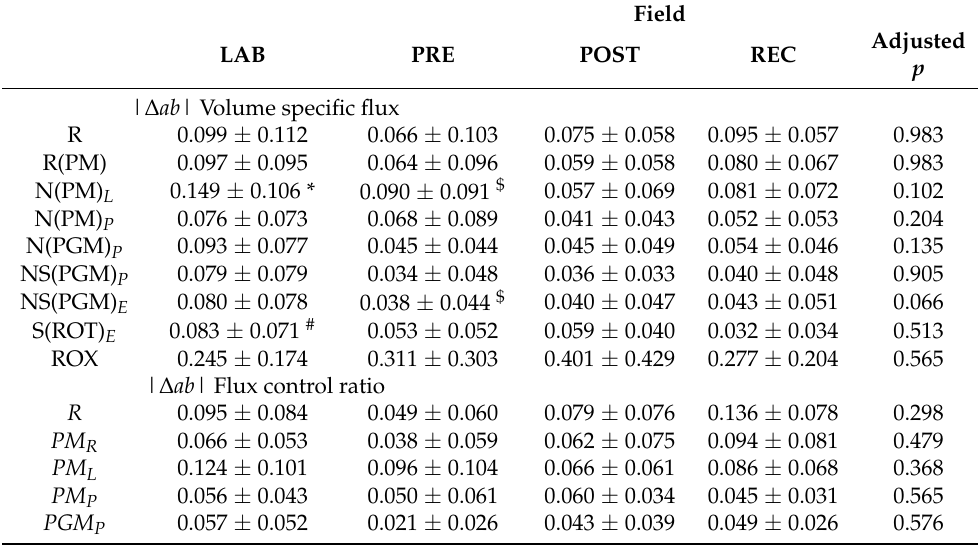
Table 6. Results of │ ∆ ab │ of J O2 and FCR .